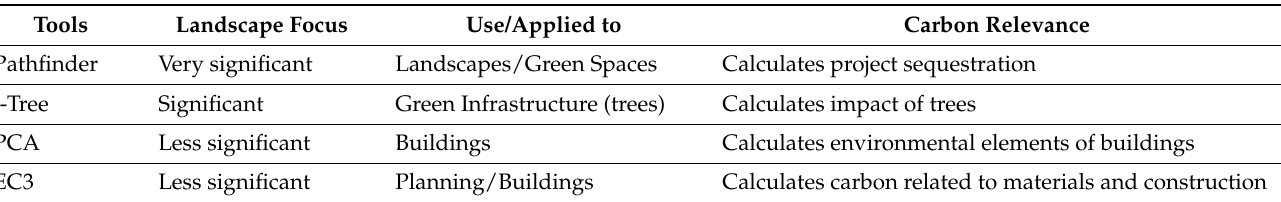
Table 1. Selected tools and key